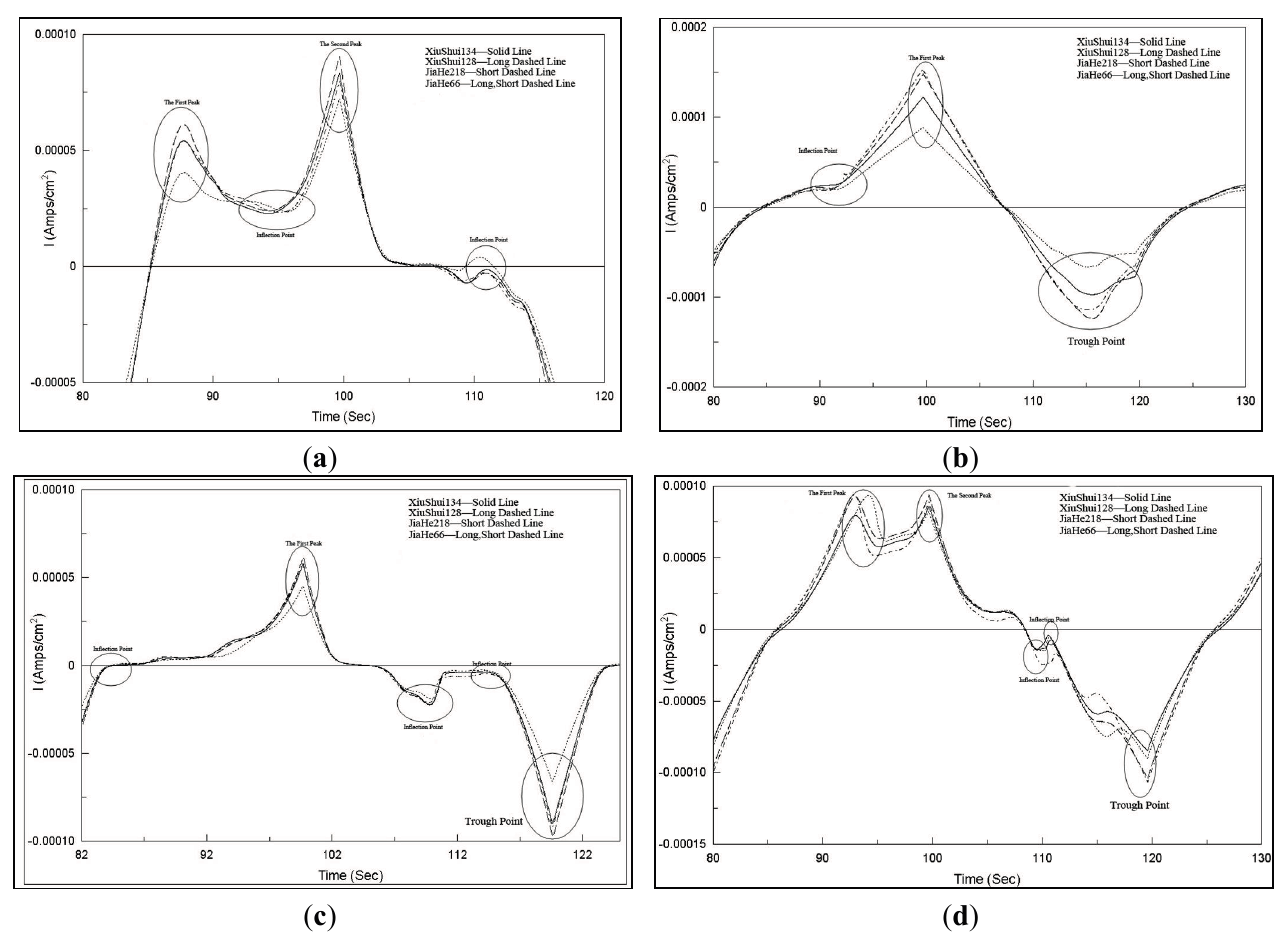
Figure 3. Current-time amplified charts of four working electrodes obtained with one time data collection for four crushed rice sample solutions. ( a ) Pt electrode; ( b ) Ag electrode; ( c ) Au electrode; ( d ) Pd electrode.